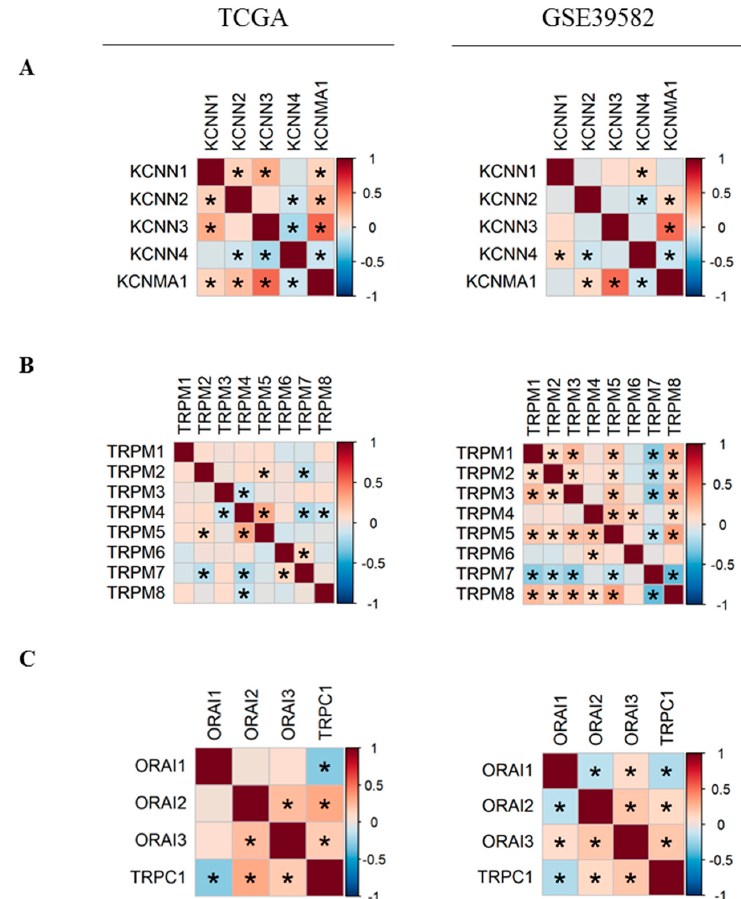
Figure 2. Pearson’s correlation heatmaps of gene expression in TCGA and GSE39582 datasets. ( A ) Pearson’s correlation heatmaps of KCa channels family coding genes; ( B ) Pearson’s correlation heatmaps of TRPM channels family coding genes; ( C ) Pearson’s correlation heatmaps of ORAI family and TRPC1 genes. Pearson’s correlation coefficients were shown with continuous gradient colors. Red represents positive correlation whereas blue represents negative correlation. Asterisk symbol correspond to correlations with BH-adjusted p -value < 0.05. TCGA: The Cancer Genome Atlas; KCa: Ca 2+ -dependent potassium channels. BH: Benjamini-Hochberg.